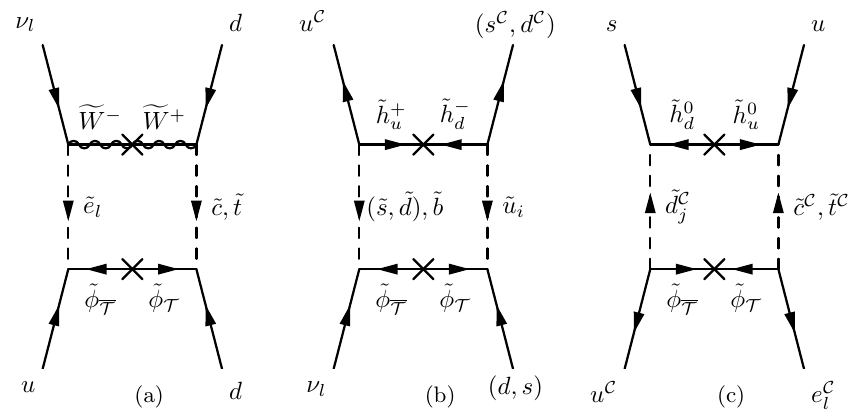
Figure 2 . Examples of dressed diagrams leading to proton decay in the model. Diagram (a) shows a contribution to p (cid:25) + (cid:22) (cid:23) l ; integrating out the triplets gives an e(cid:11)ective operator of type ! C L udue . Diagram (b) shows a C L udd(cid:23) -type operator contributing to K + (cid:22) (cid:23) l . Diagram (c) shows a C R u C d C u C e C -type operator contributing to K 0 e + , for l = 1 ; 2. Note where more than one (cid:12)eld l is listed, each choice gives a separate contributing channel, except for the dependent exchange of ( s d ) in $